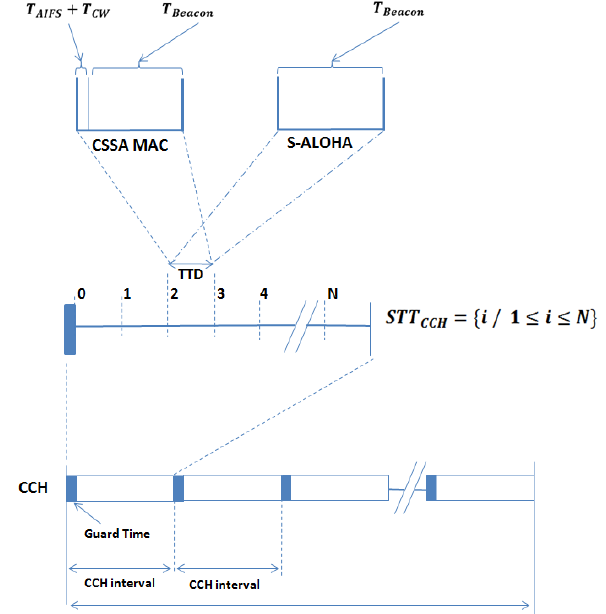
Figure 1. Sync interval, guard interval, CCH interval and TTD interval.